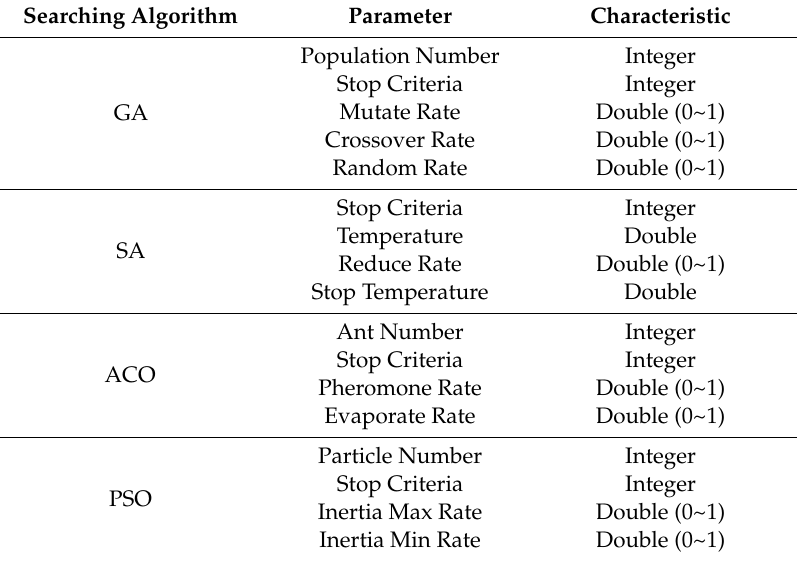
Table 8. Tuning range of the parameters.